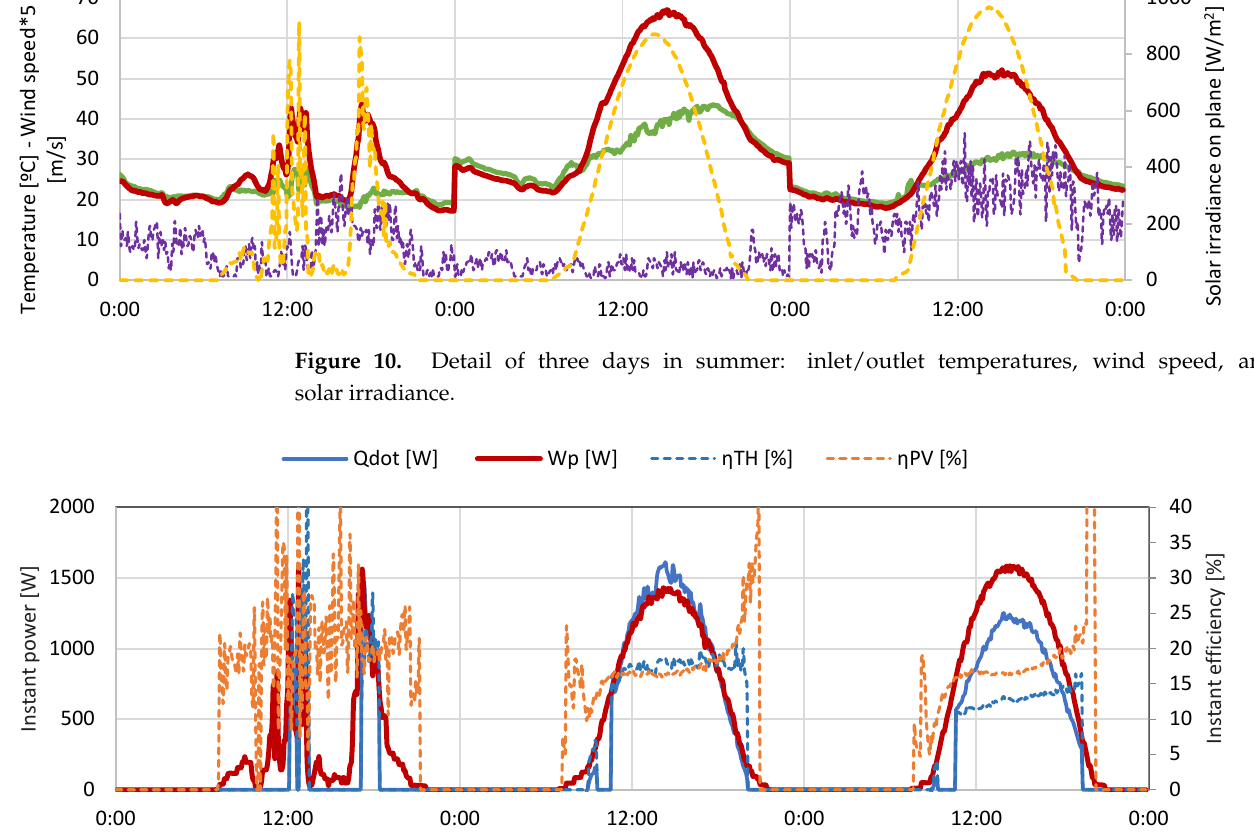
Figure 11. Detail of three days in summer: thermal and electrical power and efficiencies for a cloudy, clear, and windy day.